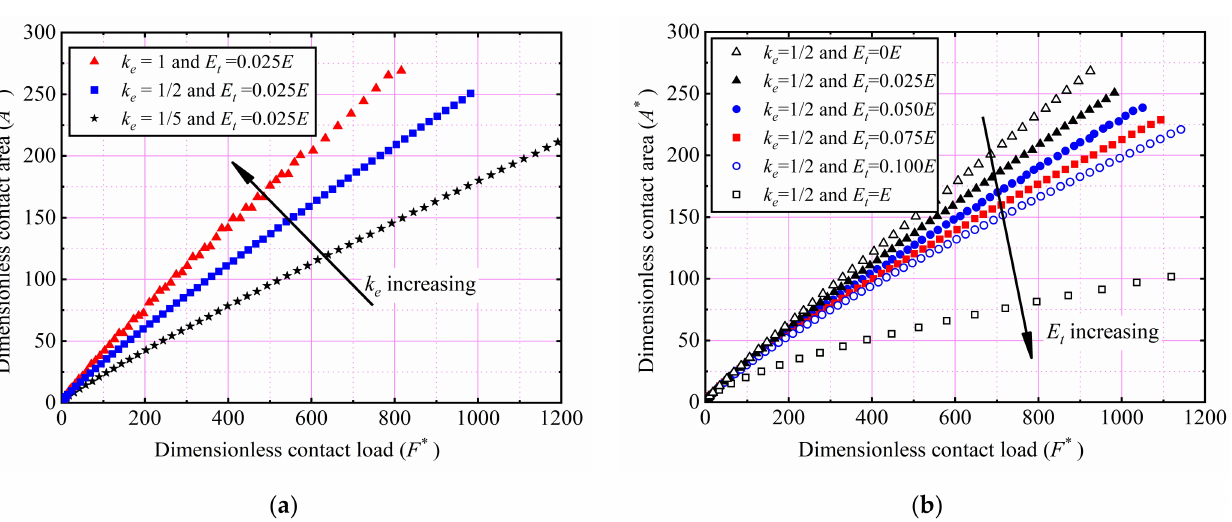
Figure 6. Evolution of A * with increasing F * : ( a ) under different k e values; ( b ) under the different E t